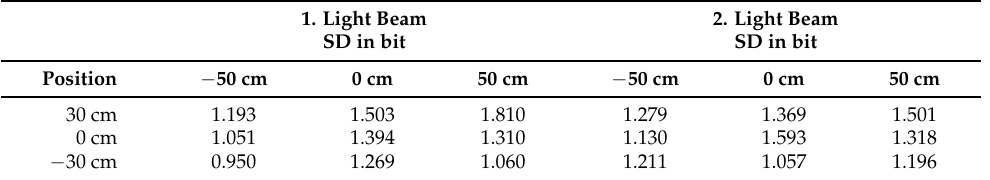
Table 2. Standard deviation of the calculated position on the LFSR sequence for the two light-beams. 1. Light Beam 2. Light Beam SD in bit SD in bit Position − 50